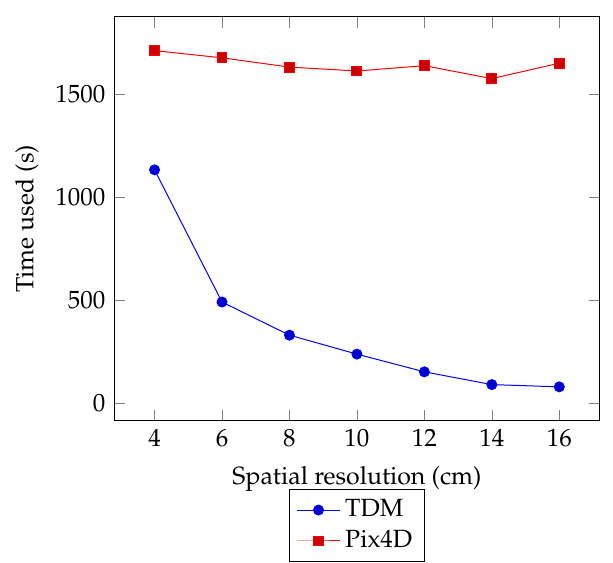
Figure 20. Time costs of TDM and Pix4D.